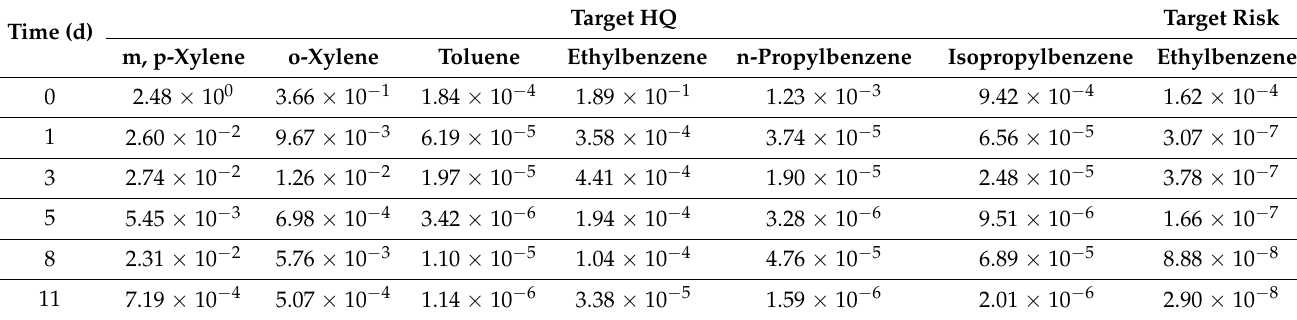
Table 2. Non-carcinogenic risks and carcinogenic risks of odour pollutants before and after applying the